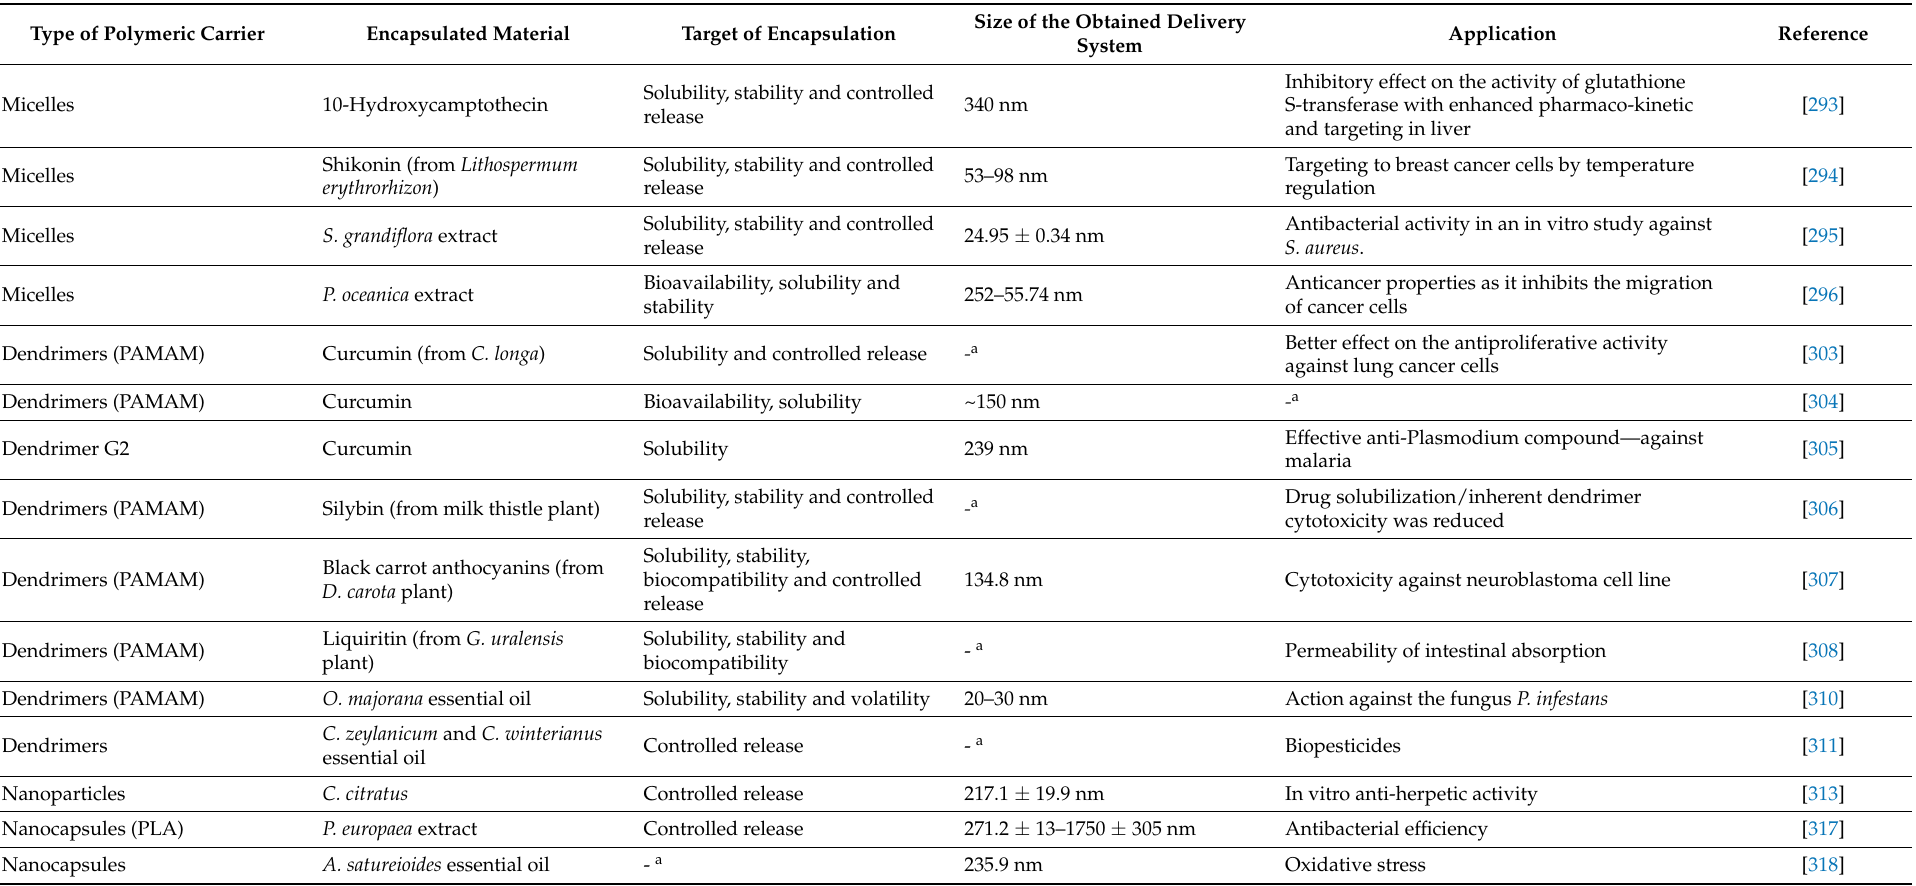
Table 3. Overview of different polymeric carriers that have been used for the encapsulation of various pure plant bioactive compounds, extracts and essential oils. Type of Polymeric